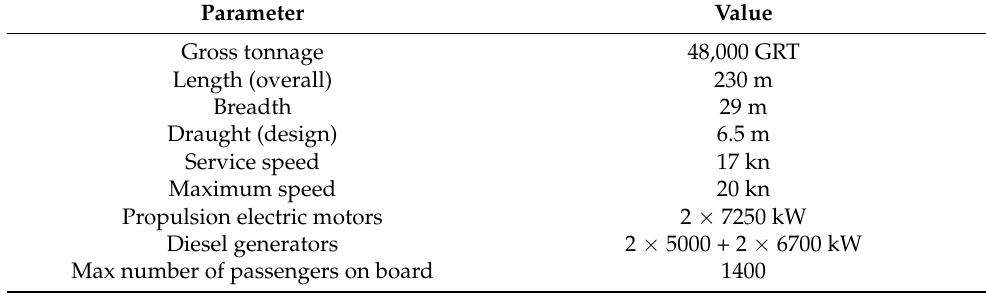
Table 1. Features of the cruise ship under study.